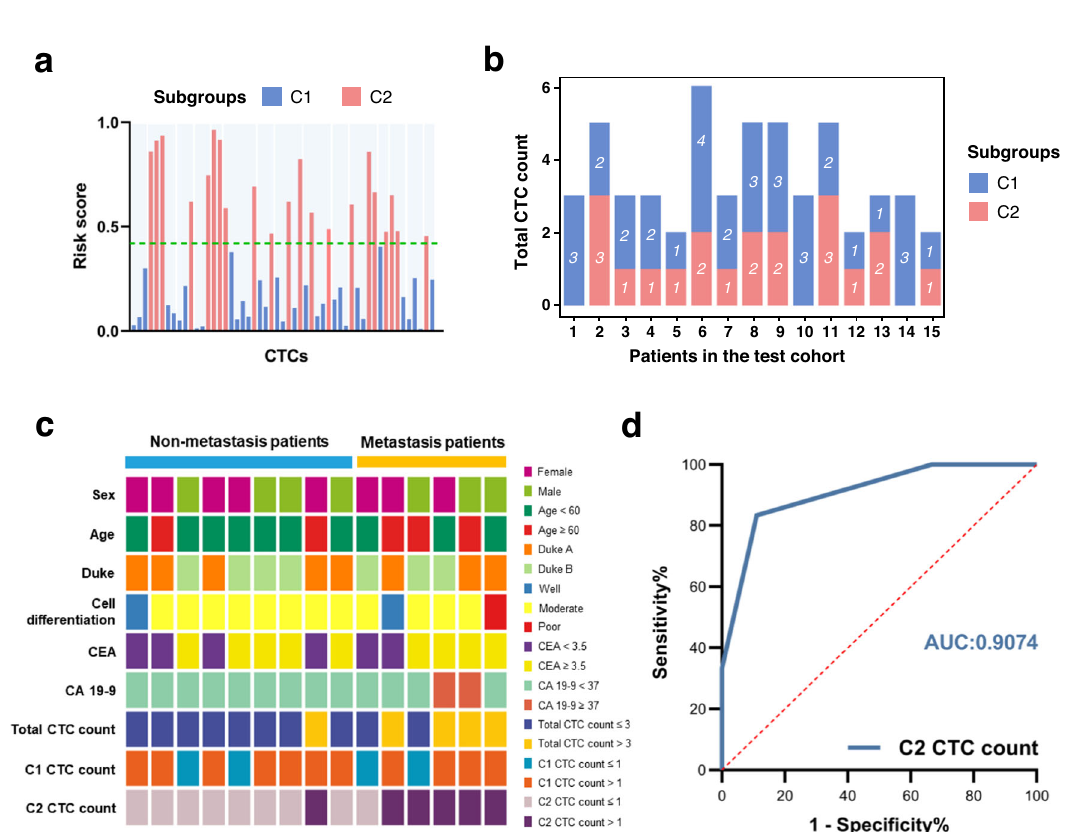
Fig. 4 | Discovery of CTC metabolic fi ngerprints based on abundance of target metabolites in single CTCs to predict colorectal cancer metastasis potential. a Clinical characteristics and biomarker levels of enrolled CTC-positive colorectal cancer patients. b Representative abundance of 11 target metabolites in single CTCs. c NMF clustering of single CTCs. Based on the obtained cophenetic corre- lation coef fi cients shown in Supplementary Fig. 11, K =2 was considered as the preferred cluster and d risk score plot of single CTCs. The risk score was con- structed as follows: Log 10 (risk score/(1-risk score))= − (0.932×abundance of glu- tamic acid)+(3.967×abundance of malic acid) − (0.166×abundance of aspartic acid) − (1.822×abundanceof lacticacid) − 3.694.Obviously, allCTCs could be split intotwogroups:lowrisk(riskscore<0.420)andhighrisk(riskscore ≥ 0.420)based on the cutoff value using the Youden index. e Correlation of patient metastasis status (metastasis vs. non-metastasis) with clinical characteristics and biomarker levels,andthenumberofCTCsincellsubgroups(C1CTCcount,C2CTCcount,and